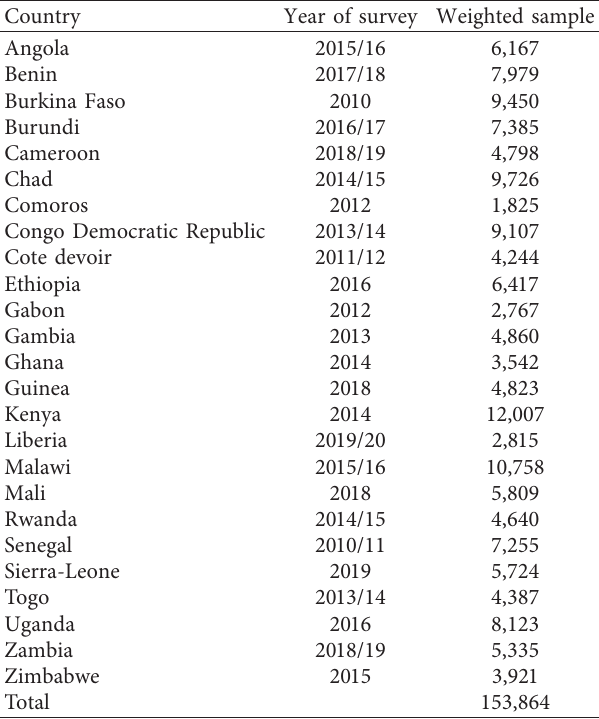
Table 1: Year of survey and weighted sample in each studied country. Country Year of survey Weighted